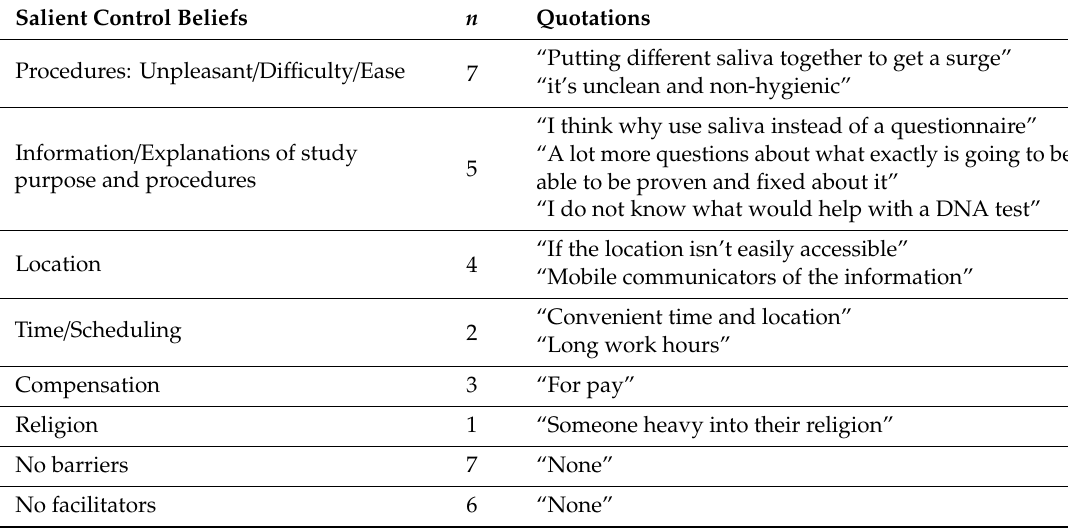
Table 3. Salient control beliefs ( n =